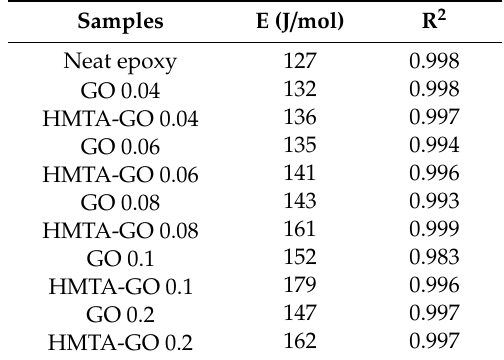
Kinetic thermodynamic parameters of epoxy composites calculated by using Horowitz-Metzger